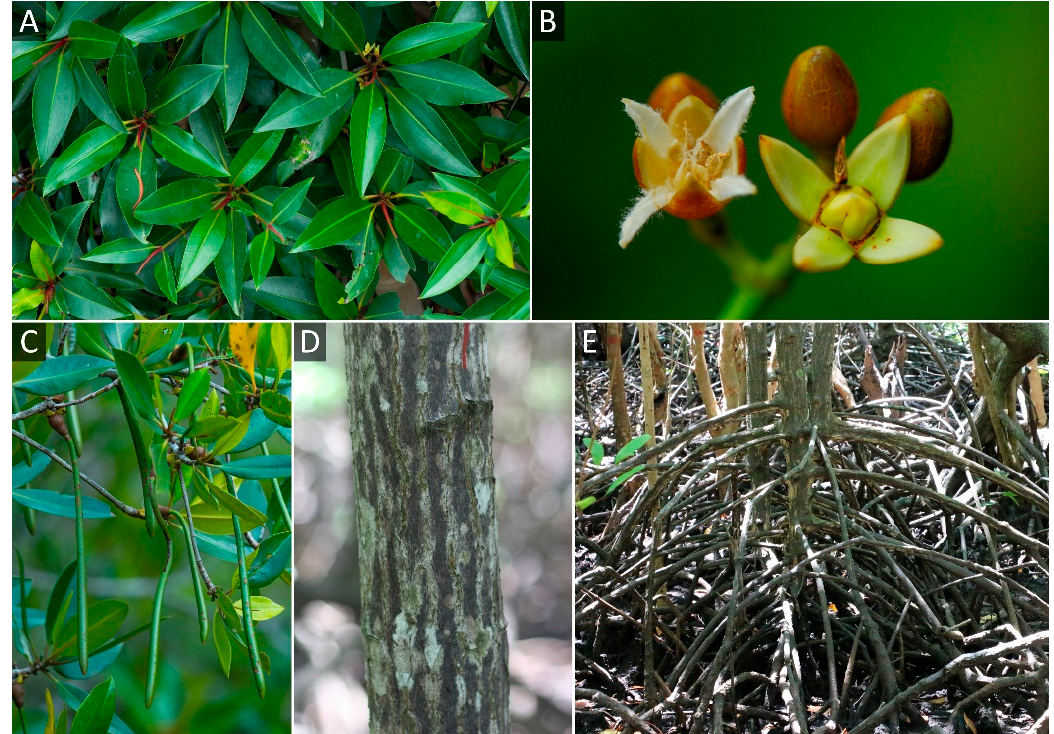
Figure 1. Morphology of R. apiculata in Thailand. ( A ) Leaves. ( B ) Flowers. ( C ) Fruits. ( D ) Bark. ( E ) Aerial roots.